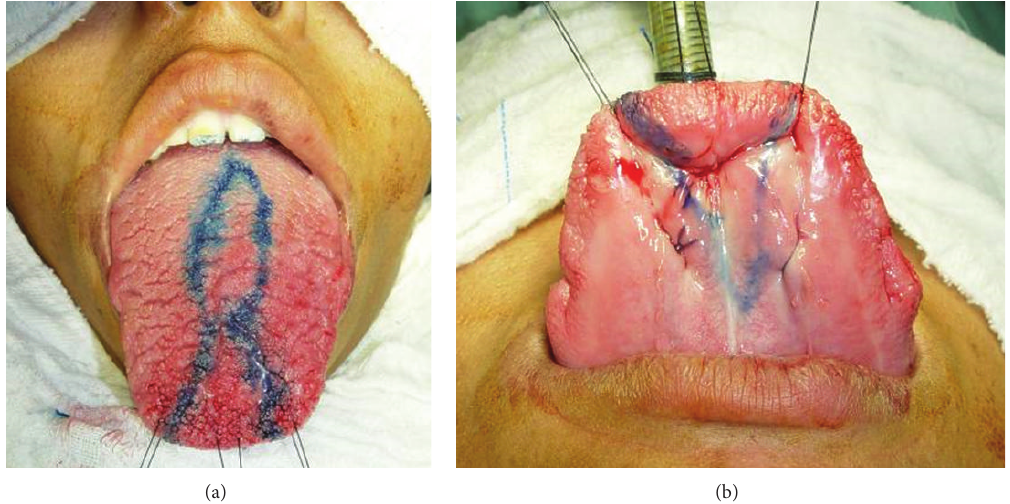
Figure 2: The tongue was pulled out of the oral cavity through three repairs with nylon suture 3-0 fixed to the surgical field to maintain the symmetry between the sides and facilitate the demarcation of the incisions, which was performed which methylene